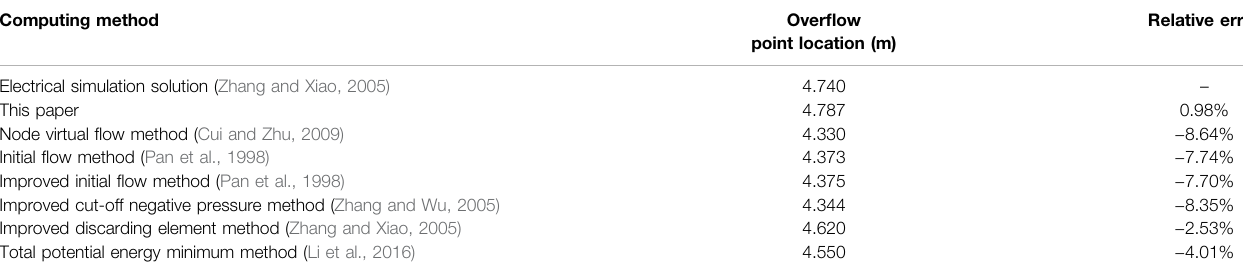
TABLE 2 | Accuracy comparison of over fl ow points with published